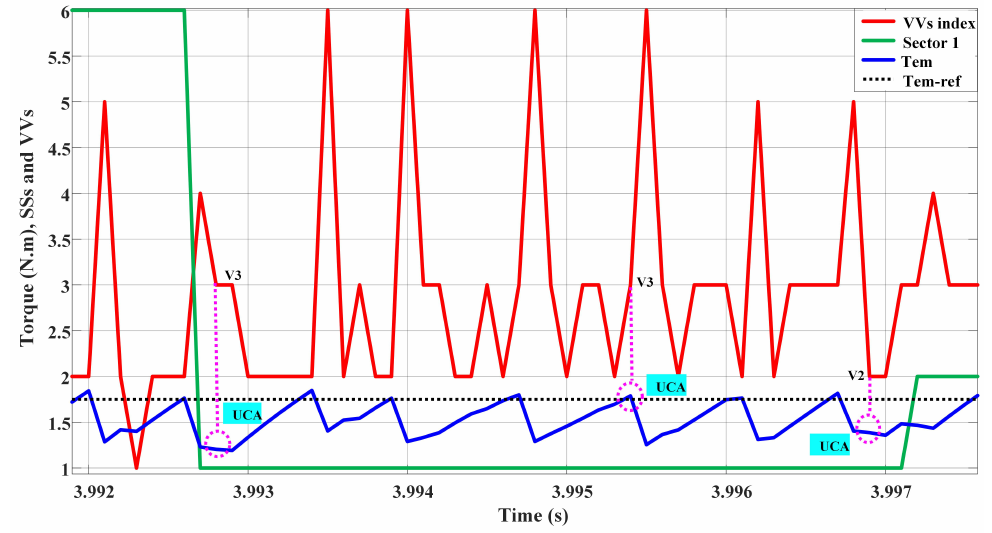
Figure 22. Torque response and applied voltage vectors of (6-sector) DTRFC strategy at high